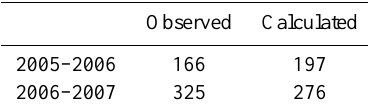
Table 5. Observed and calculated mass balances (mmw.e.) at the summit of the Gregoriev Glacier for the two observational